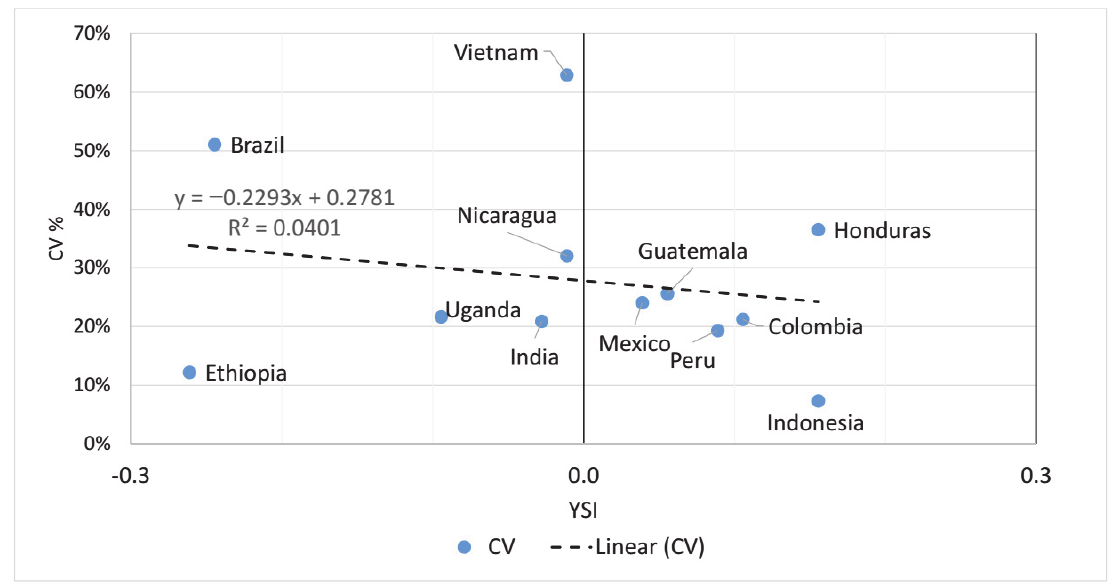
Figure 4. YSI vs. CV% scatterplot for coffee yields, 1961–2020, 12 countries. Source: authors’ own elaboration. As we indicated earlier, the 60 ‐ year time period is not homogeneous; the temperature